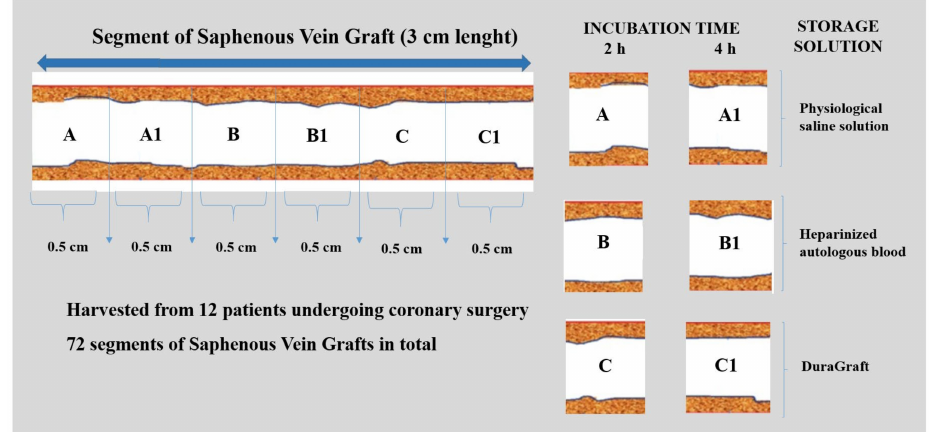
Figure 1. Experimental condition. Each segment of fresh saphenous vein was divided into six sections that were 0.5 cm in length. Two incubation time sets were tested: 2 h and 4 h for each vein preservation